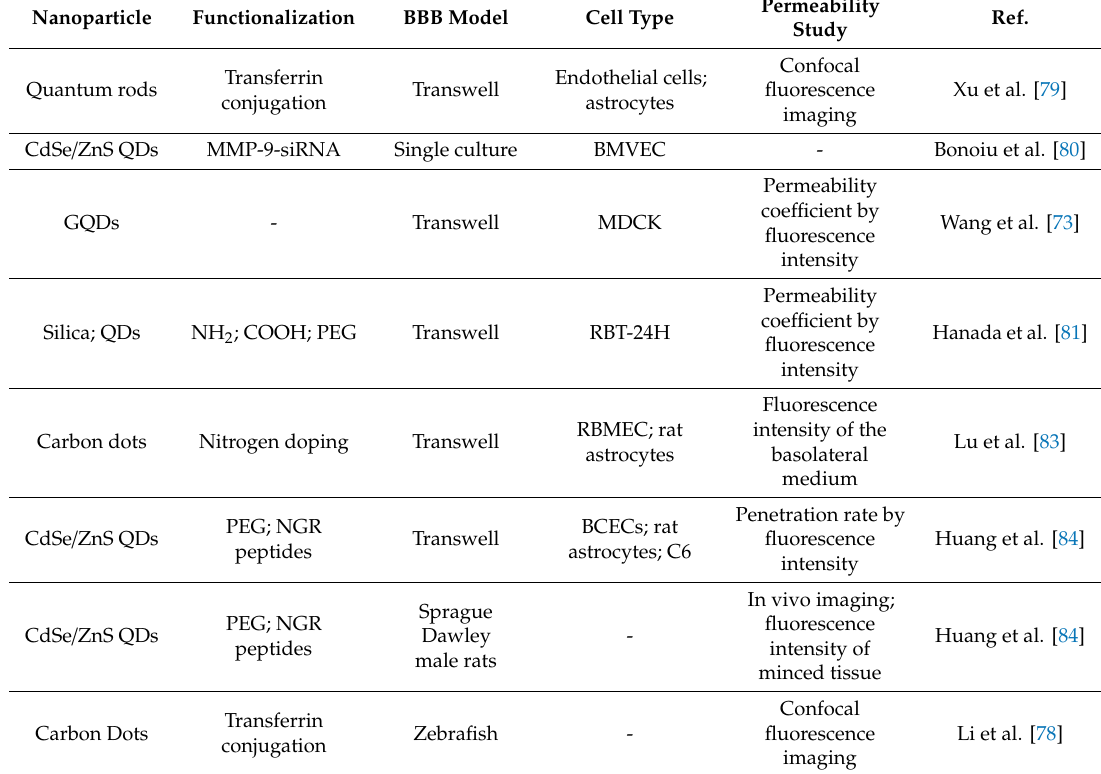
Table 2. QDs designed to overcome the blood-brain barrier